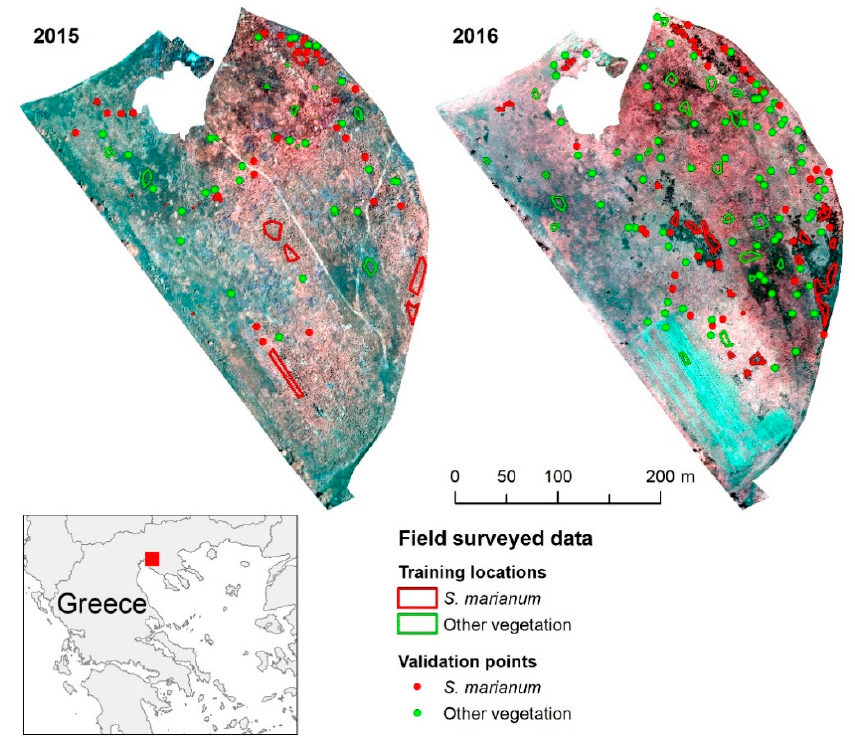
Figure 1 . Location of study area, unmanned aerial vehicle (UAV) orthomosaics acquired on 19 May 2015 and 22 April 2016, and field-surveyed data.